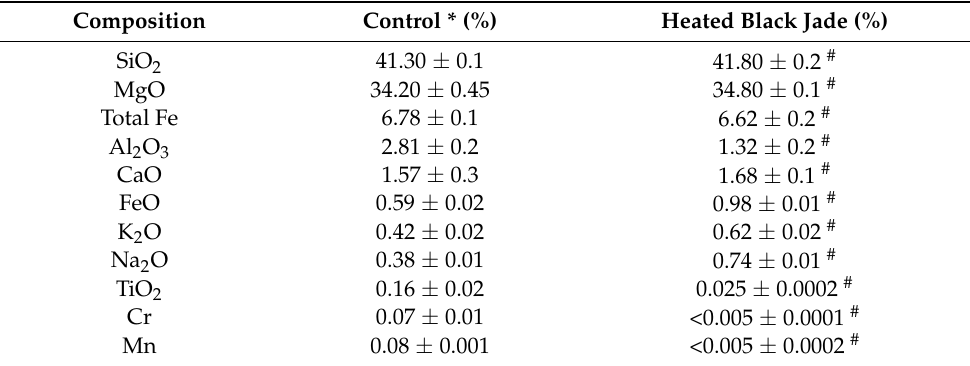
Table 2. Comparison of compositions and contents between the black jade and the heated black